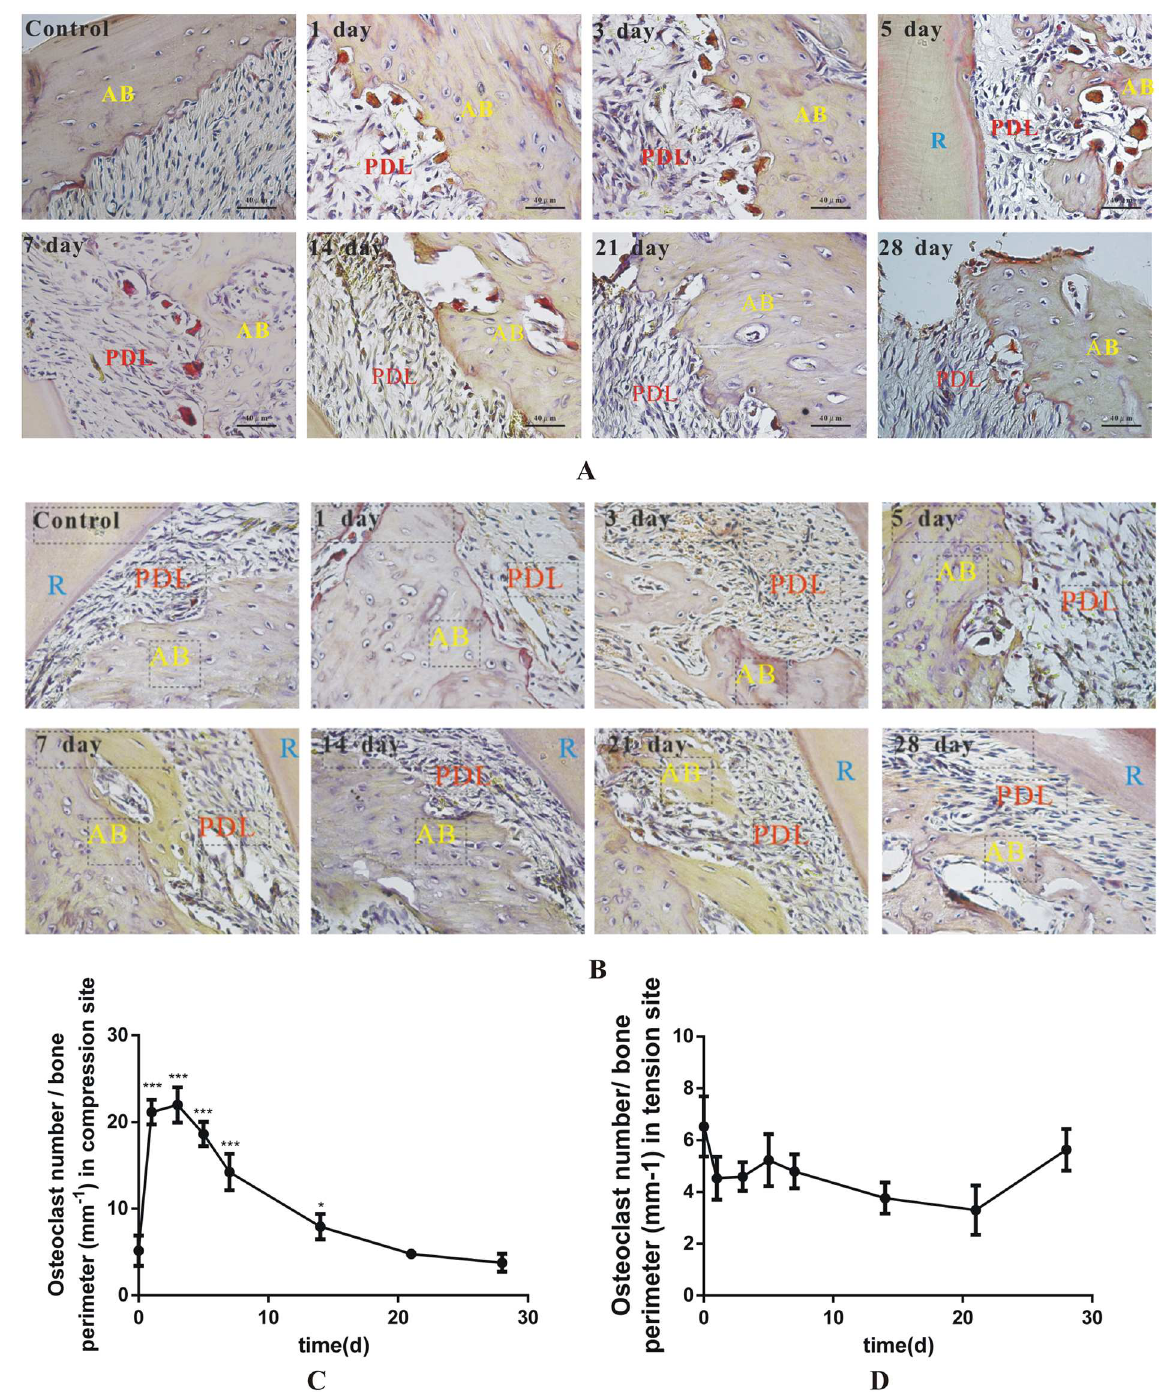
Fig 3. The TRAP staining results showed that the osteoclastic activity was consistent with the sclerostin level at the compression sites during tooth movement. (A) The TRAP-staining results in the compressionsites at 0 d, 1 d, 3 d, 5 d, 7 d, 14 d, 21 d and 28 d during tooth movement. The TRAP-positive cells were identified as red multinuclear cells near the alveolarbone. Alveolar bone(AB), PDL (periodontal ligament), R (root). (B) The TRAP-staining results in the tensionsites at 0 d, 1 d, 3 d, 5 d, 7 d, 14 d, 21 d and 28 d duringtooth movement. The TRAP-positive cells were identified as red multinuclear cells near the alveolarbone. Alveolar bone(AB), PDL (periodontal ligament), R (root). (C) The quantification of TRAP-positive cells per bone surface (mm -1 ) at the compression sites. The numberof active osteoclasts increasedto the apex in the first three days and graduallydecreasedwith time. * p < 0.05vs 0 d, *** p < 0.001vs 0 d. (D) The quantification of TRAP-positive cells per bone surface (mm -1 ) at the tensionsites. The numberof active osteoclastsincreasedto the apex in the first three days and graduallydecreased with time.